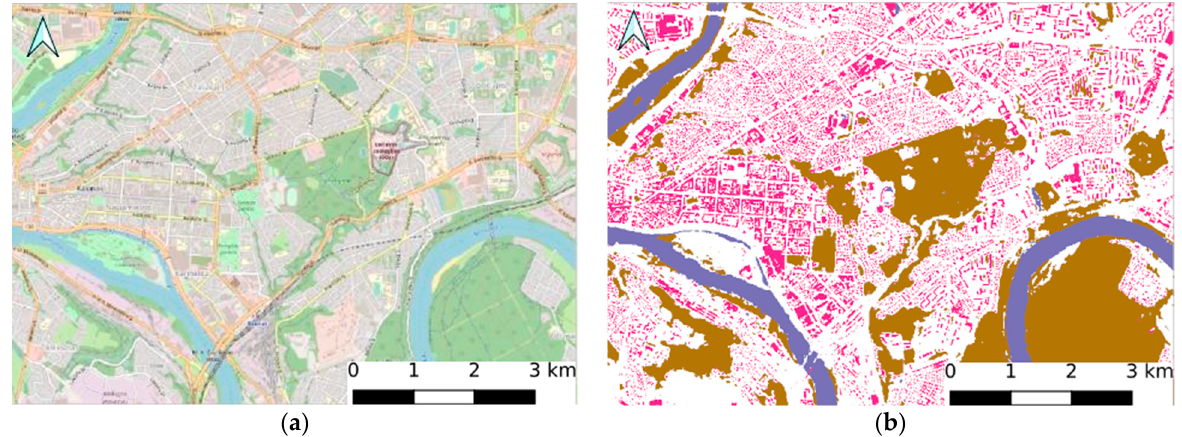
Figure 12. The segmentation results on the finest level: ( a ) OSM map view of Kaunas city center; ( b ) processed data of Kaunas city center of the selected time period (2009–2010) with segmented buildings (magenta), water (blue), forest/trees (brown), and other (white) categories.